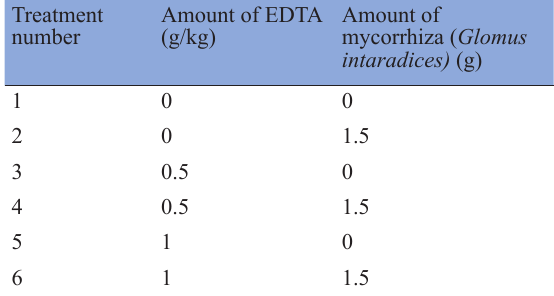
Table 1 : Treatments applied